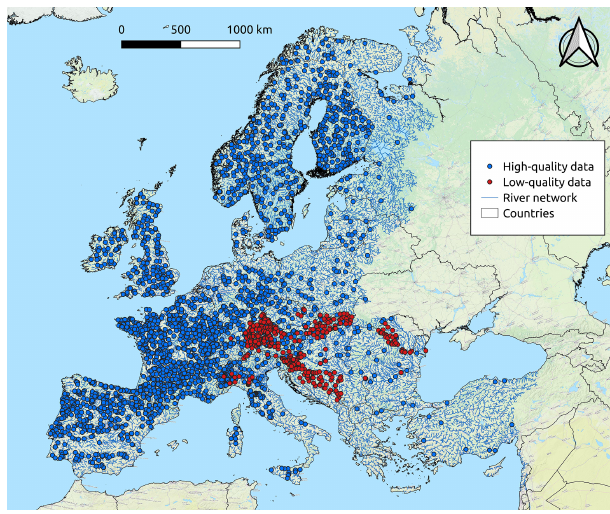
Figure 2. Stream gauges (2858) retained from the DG-JRC database. Blue and red points refer to high- and low-quality data,